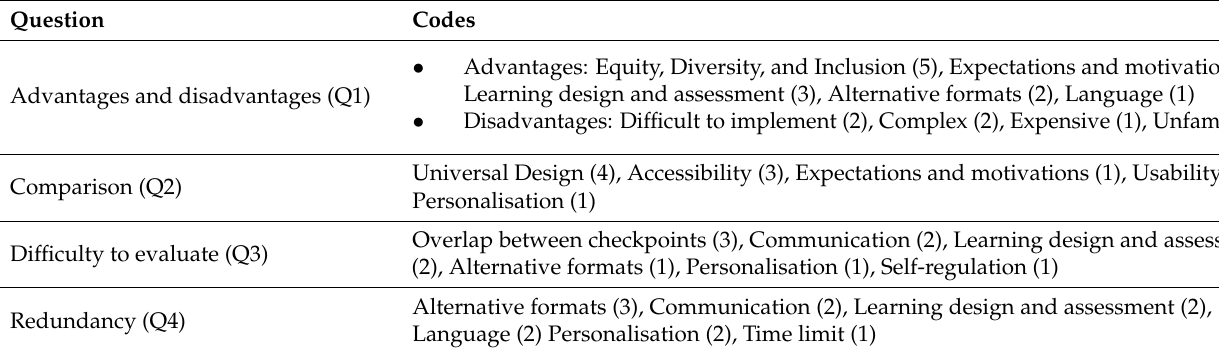
Table 3. Codes derived from students’ perceptions of